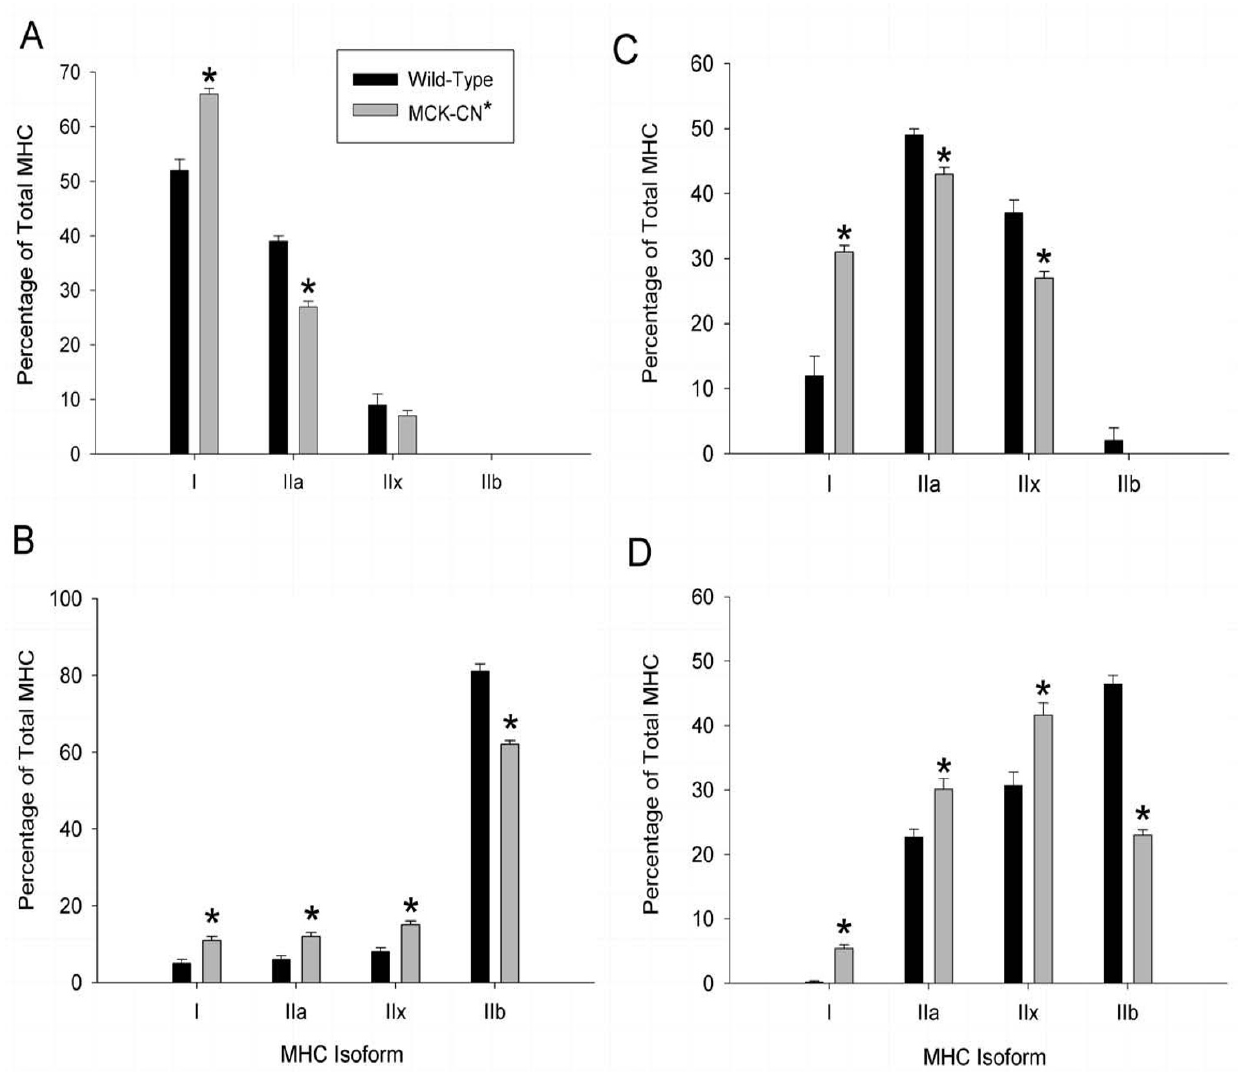
Figure 2 Adult myosin heavy chain (MHC) isoform proportions of the soleus (A), medial gastrocnemius (B), diaphragm (C), and plantaris (D) muscles of wild-type (dark bars) and MCK-CN* transgenic (gray bars) mice as determined by SDS-PAGE of whole muscle extracts. The * denotes significantly different from wild-type at p ≤ 0.05. Note the elevated proportions of slower MHC iso- forms in the transgenic mice compared to